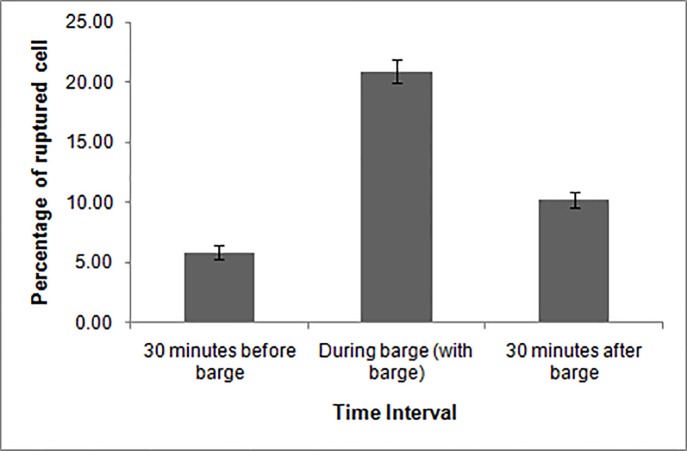
Quantum of phytoplankton cell with respect to barge damaged movement.